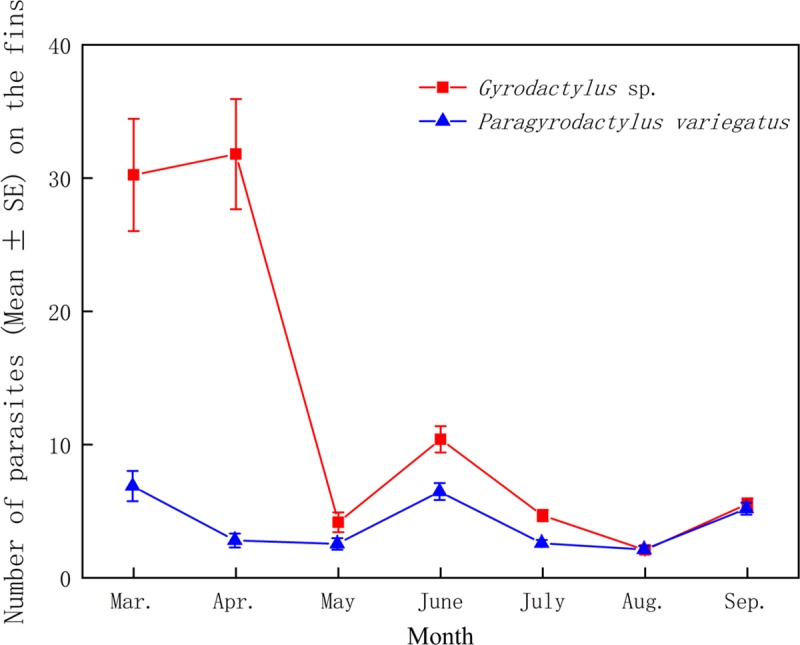
Parasites number (mean±SE) of Gyrodactylus sp. and Paragyrodactylus variegatus on total fish fins by month.